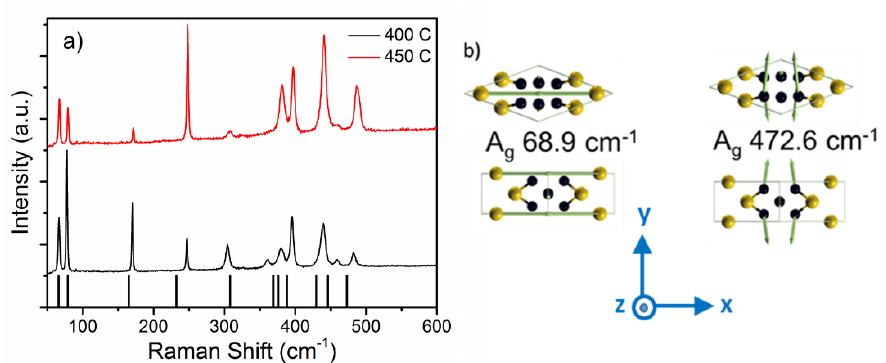
Figure 3. ( a ) Raman spectra from Au 2 P 3 film on Au deposited at 400 °C, 450 °C, and calculated Raman modes. ( b ) Schematics of atomic vibrations, for example low-frequency and high-frequency Raman modes; the inset shows the Cartesian axis orientation, with axis 𝑎 parallel to x and axis 𝑐 parallel to 𝑦 .